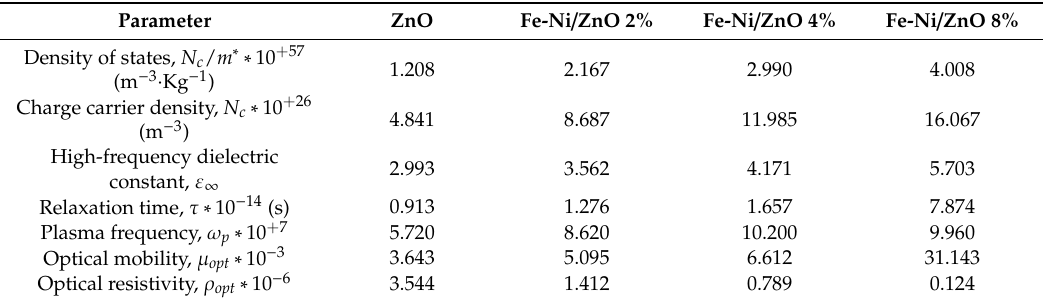
Table 1. Estimation of some essential optoelectronic constants of ZnO and (Fe-Ni) co-doped ZnO thin films for di ff erent (Fe-Ni) co-doping